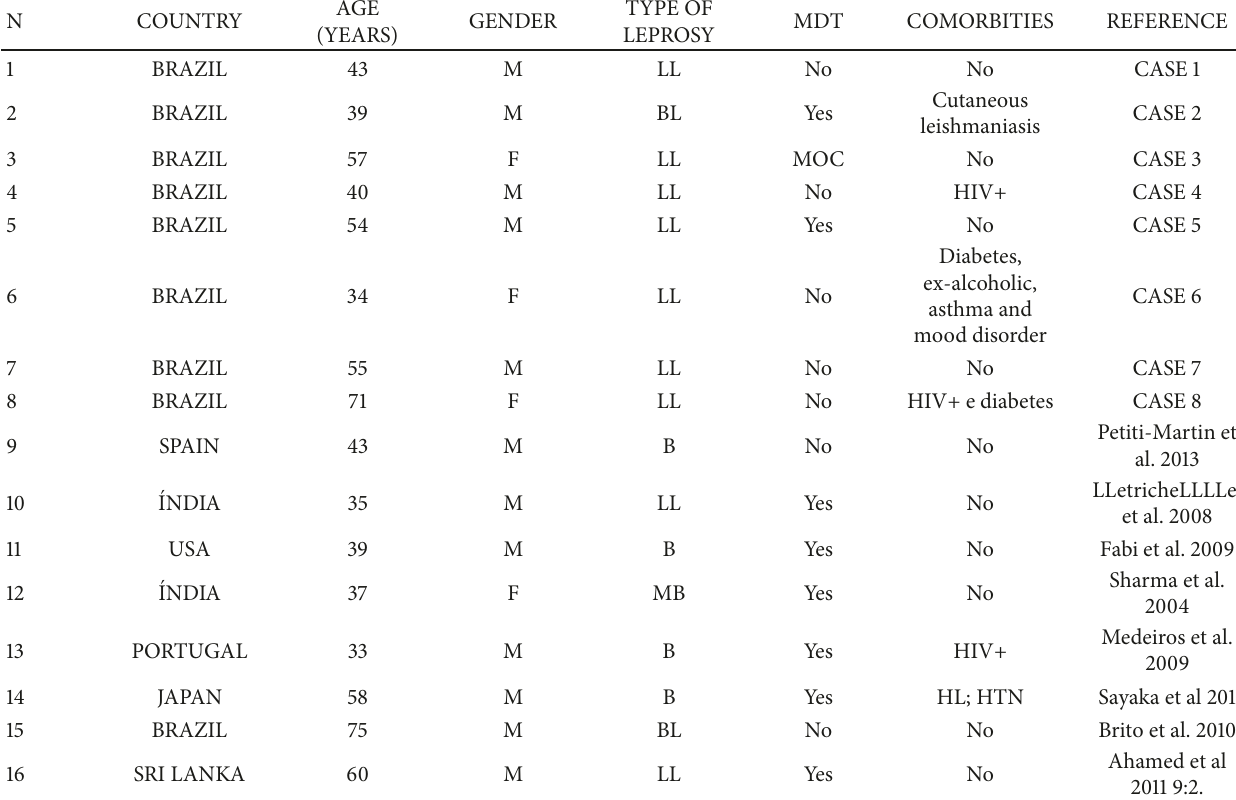
Table 1: Reports of ENL complicated by thrombosis during thalidomide/corticosteroids